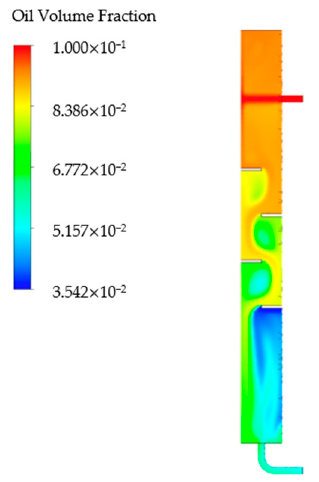
Figure 6. Oil phase volume distribution of the spiral orbit.